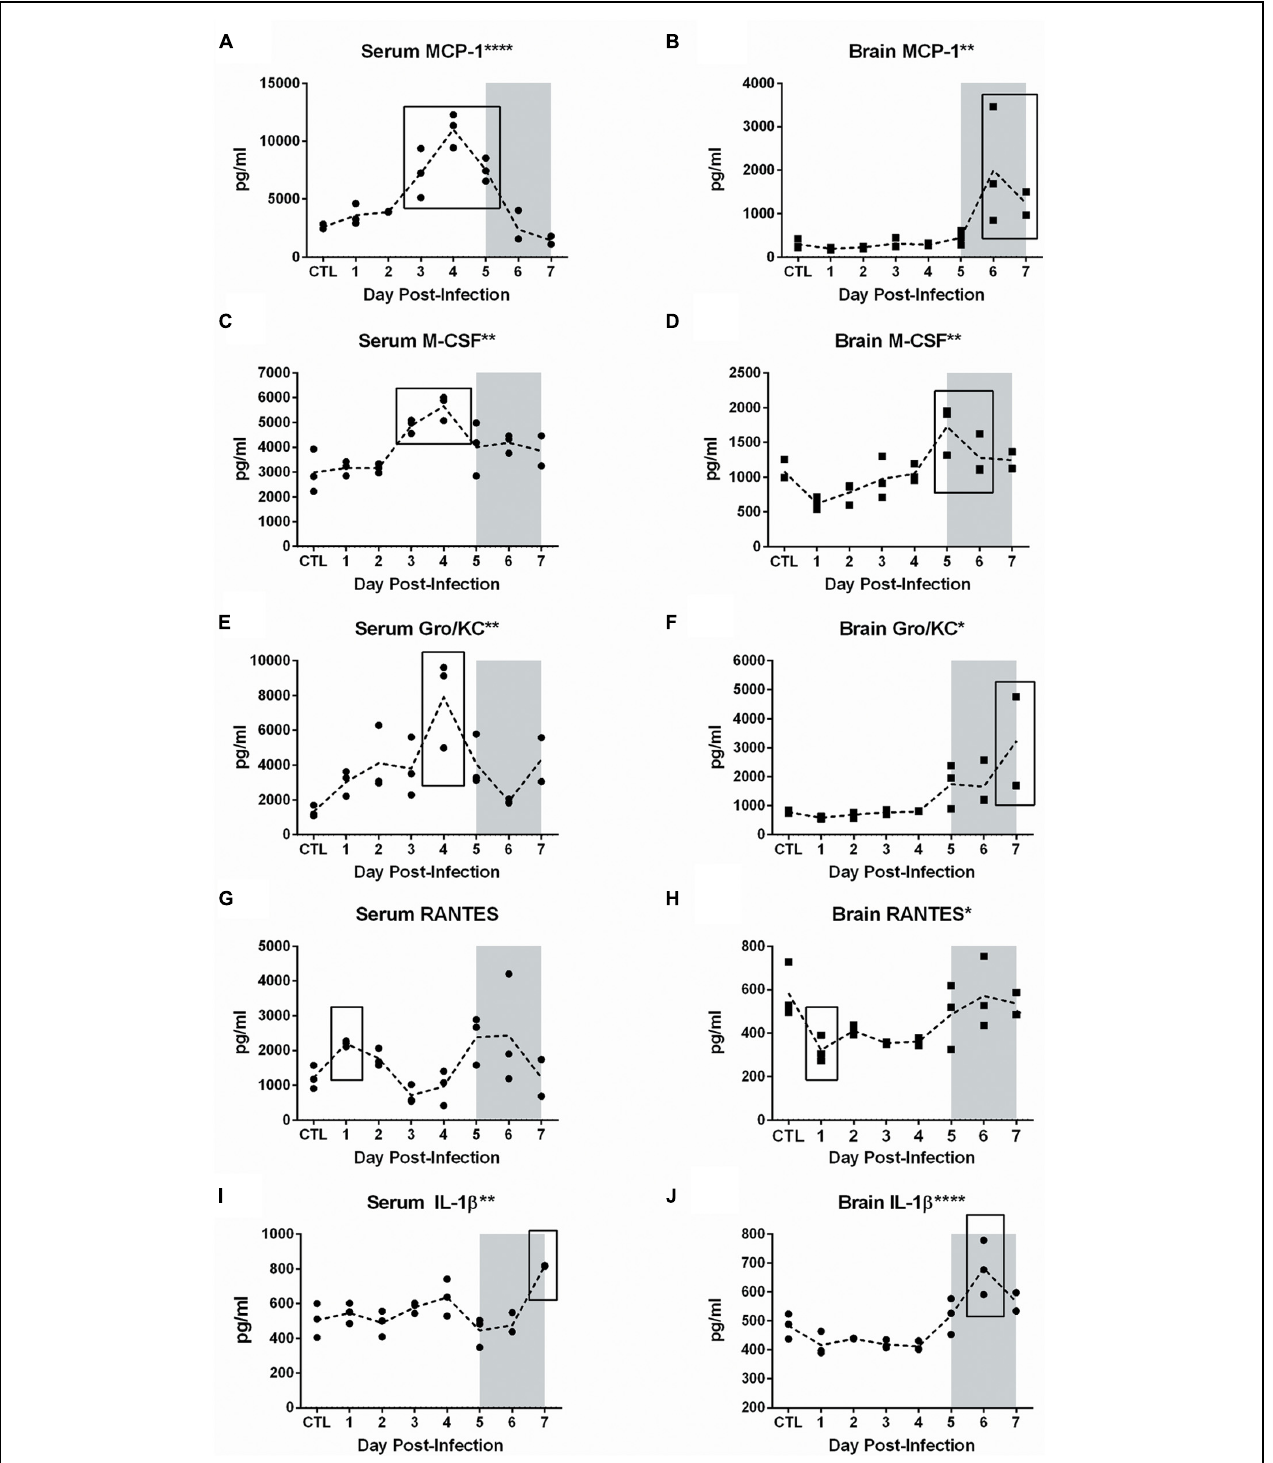
FIGURE 8 | Cytokine and chemokine dysregulation in serum and brain of RVFV-infected Lewis rats. Serum and homogenized brain tissue were analyzed using the Bio-Plex Pro Rat Cytokine 23-plex assay. All analytes were tested for significance using one-way ANOVA. The five cytokines shown in this figure were statistically significant for both serum (left column) and brain (right column). The level of significance by ANOVA is reflected by the number of asterisks on each graph title, where ∗ p ≤ 0.05, ∗∗ p ≤ 0.01, ∗∗∗ p ≤ 0.001, ∗∗∗∗ p ≤ 0.0001. Individual time points were compared to uninfected controls by t -test. Significant time points are indicated by the black box. The gray shaded box on all graphs represents the window of clinical disease (5–7 dpi).